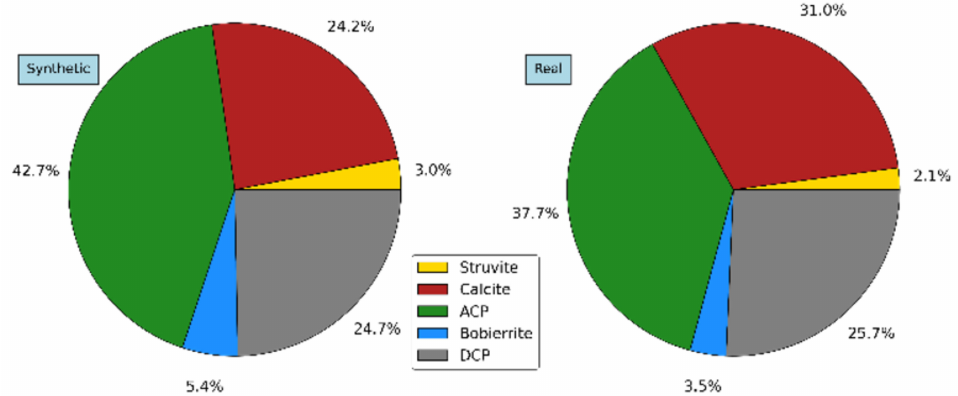
Figure 10. Composition of final precipitates with synthetic (left) and real (right)